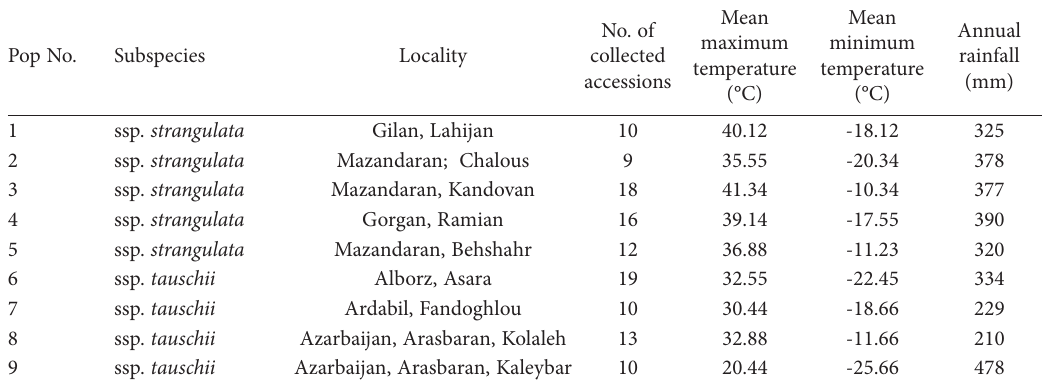
Table 1. Populations studied, their locality and ecological features of Ae. tauschii in this study.